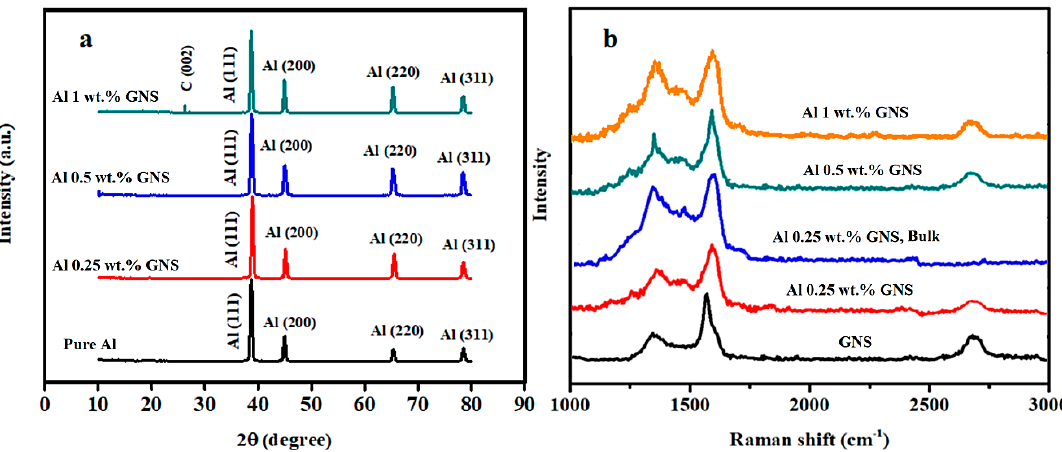
Figure 3. ( a ) X-ray diffraction patterns of aluminum and consolidated Al/graphene nanosheet (GNS) nanocomposites; ( b ) Raman spectra of pure GNSs, the ball milled Al-GNS powders with different weight percent, and consolidated 0.25 wt.% Al-GNS nanocomposite (bulk).